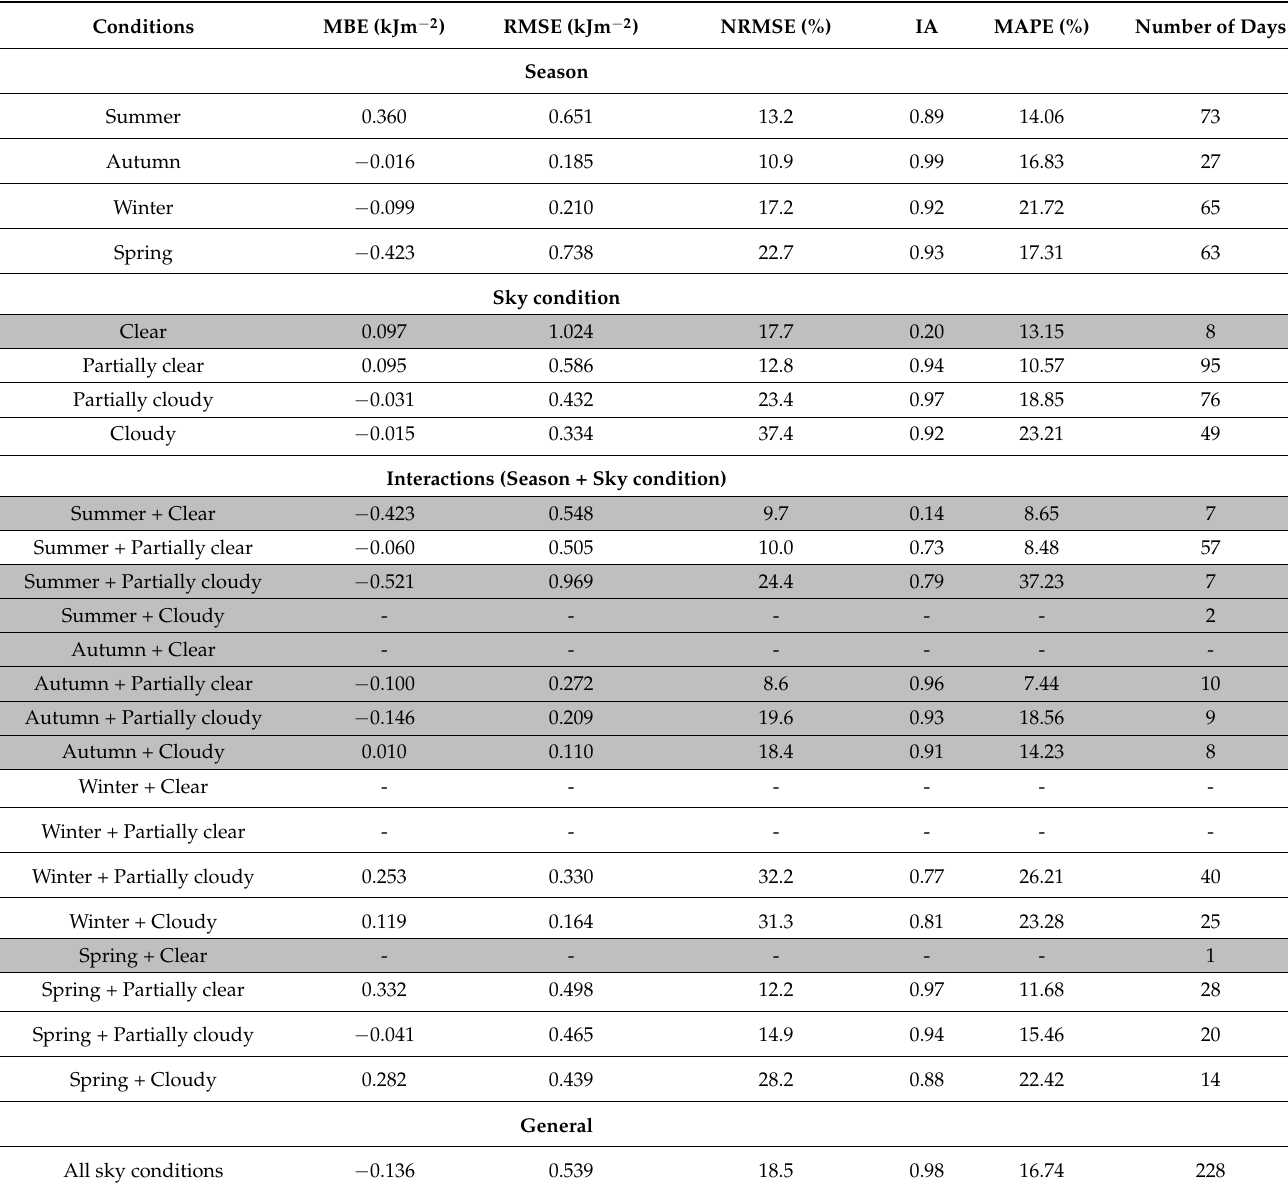
Table 5. Same as Table 4, but for daily